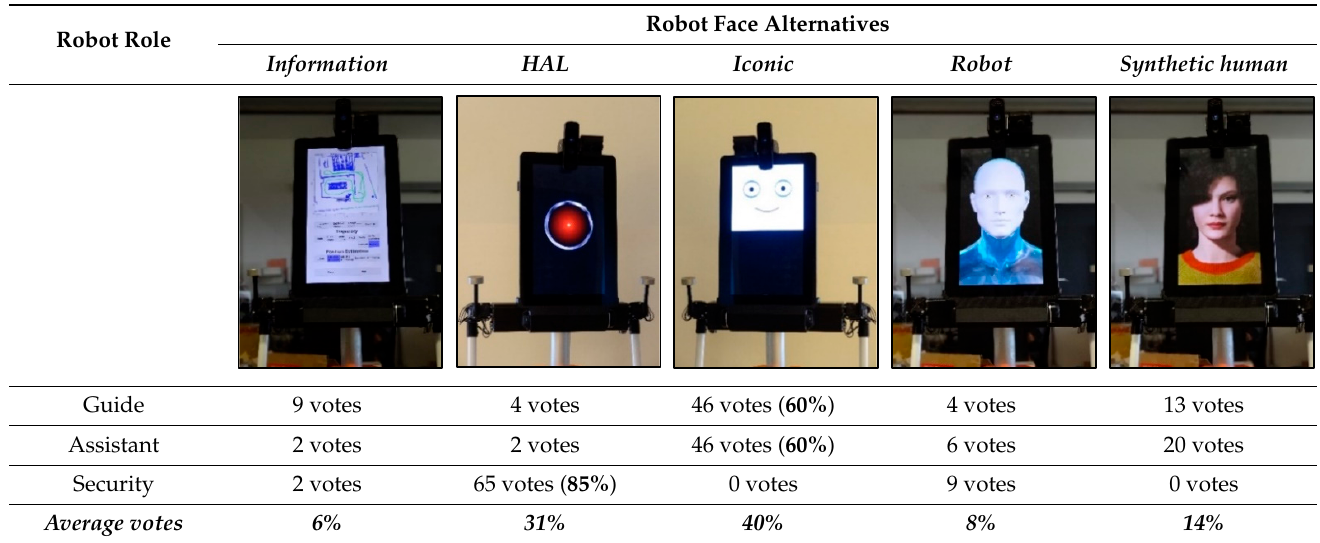
Table 5. Alternatives considered to implement the face of the mobile robot in different applications and votes received.